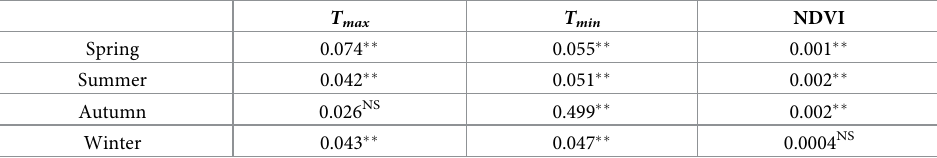
Table 1. Statistics of trends in seasonal T max / T min and NDVI from 1982 to 2015.